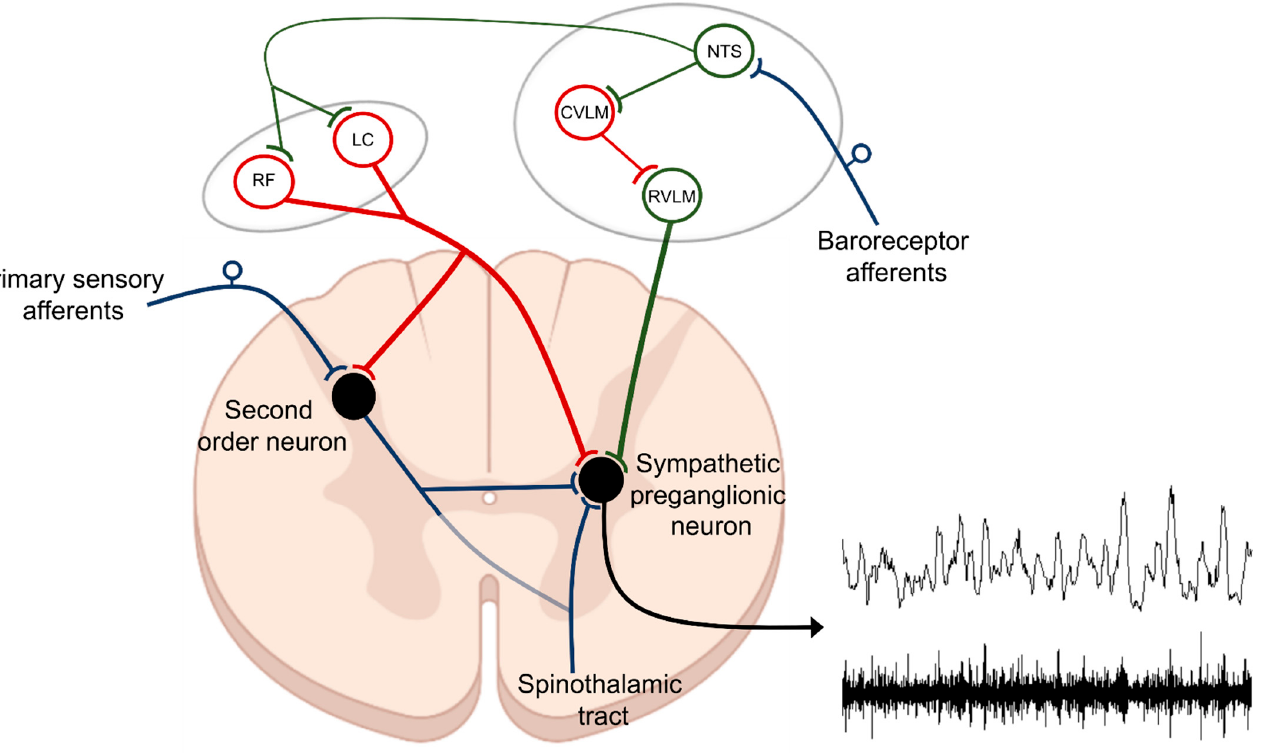
Figure 1. Control of sympathetic preganglionic neurons. Efferent sympathetic nerve activity (SNA) is determined by the net product of excitatory and inhibitory projections to sympathetic preganglionic neurons located within the intermediolateral (IML) cell column of the thoracic spinal cord. The rostral ventrolateral medulla (RVLM) is one of the main sources of descending excitatory drive (green). Additionally, second-order sensory neurons, relaying information from primary sensory afferents, are an important intraspinal source of excitatory drive to sympathetic preganglionic neurons. Descending inhibitory projections to sympathetic preganglionic neurons (red) arise from multiple brain regions including from the locus coeruleus (LC) and the reticular formation (RF). Much of the descending excitatory and inhibitory drive to sympathetic preganglionic neurons is regulated by neurons located within the nucleus of the solitary tract (NTS), which is the primary integrative site for baroreceptor and chemoreceptor afferent fibers which drive autonomic reflexes. Included above is an example of raw (lower tracing) and integrated (upper tracing) SNA recorded from postganglionic renal sympathetic nerve fibers in a rat as described in [63] (lower right).